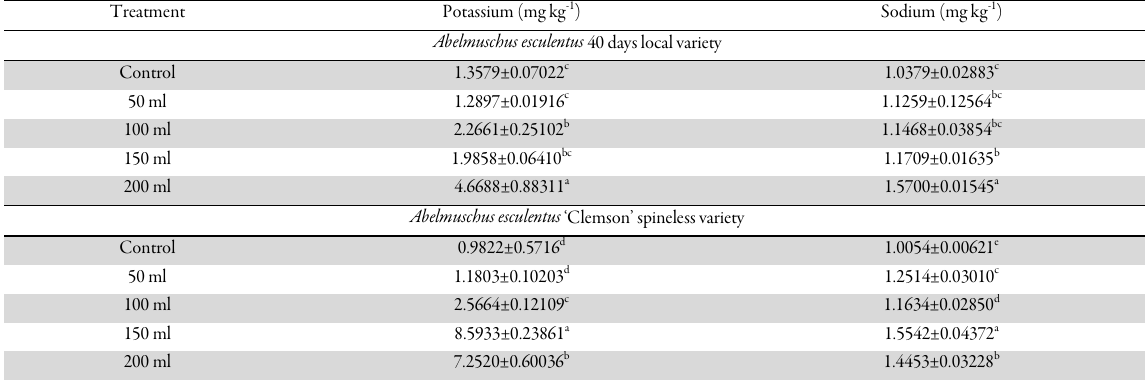
Table 12. Nutrient contents of control and treatment plants as affected by different concentrations of spent engine oil